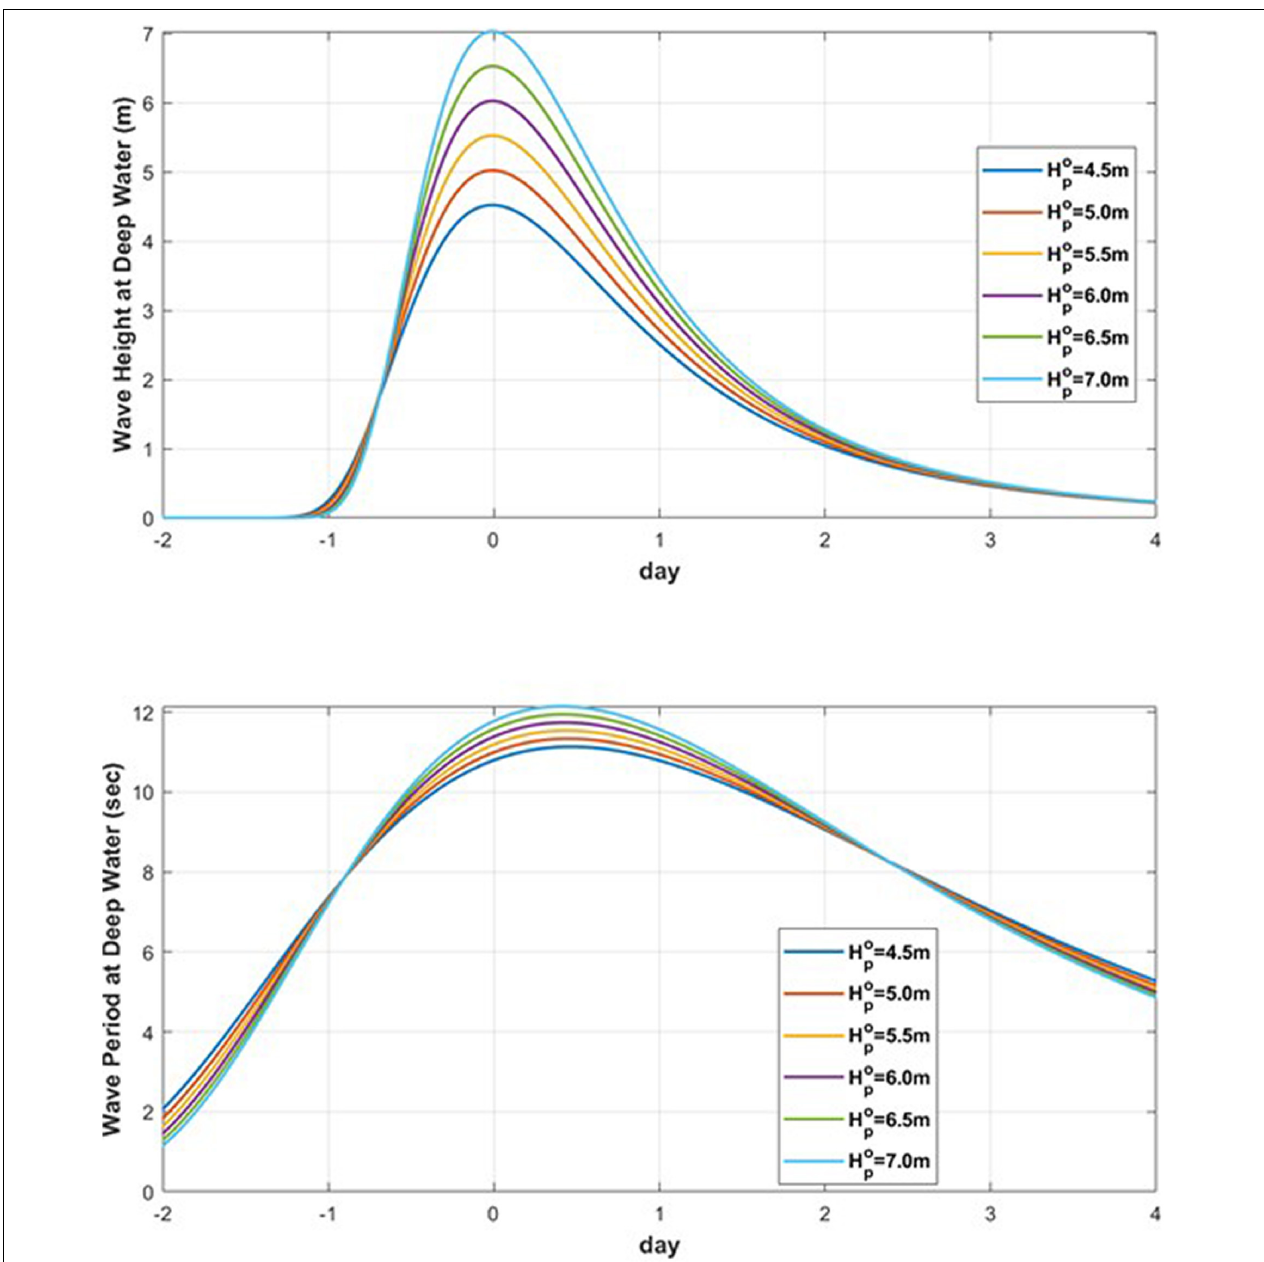
FIGURE 4 | Temporal variation of storm wave height (Up) and wave period (Down) in deep water with respect to H o p